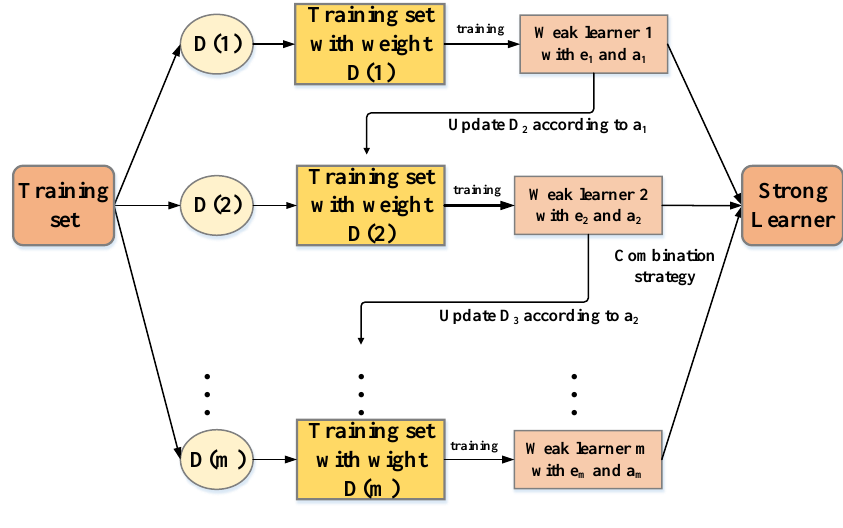
Figure 7. Adaboost algorithm flow chart.